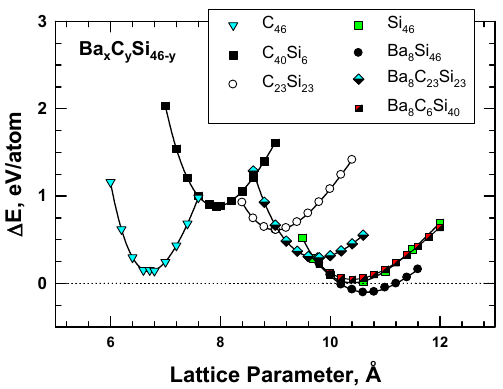
Figure 3. Energy change curves for selected Type I clathrate compounds of Ba 8 C y Si 46-y , C 46 , C 40 Si 6 , and C 23 Si 23 compared to those of Si 46 and Ba 8 Si 46 . From Chan et al. [8]. Reprinted with permission from Springer.